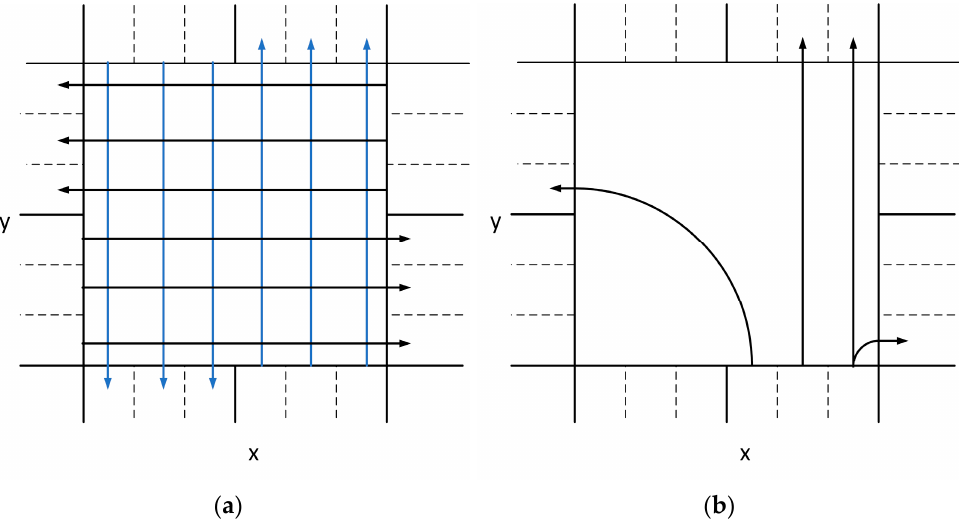
Figure 23. 2D intersection model of ( a ) Scenario 1: when all UAVs move straight and ( b ) Scenario 2: when UAVs can turn left, move straight, or turn right. The blue arrows represent the paths of the UAVs from the north and south ways, while the black arrows represent the paths from the east and west ways.